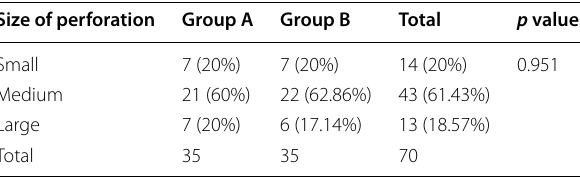
Table 1 Comparison of size of perforation between group A and group B